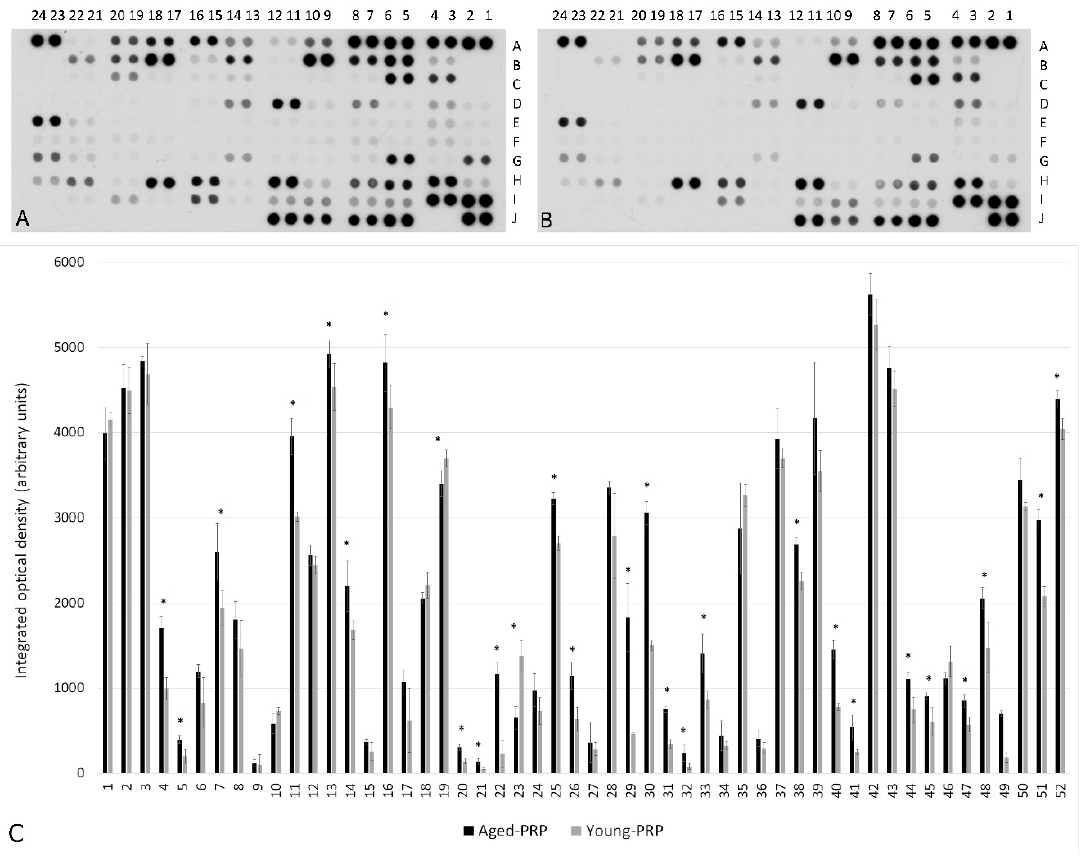
Figure 2. Molecular analysis of Young and Aged PRPs. Cytokine array of Aged PRP ( A ). Cytokine array of Young PRP ( B ). Molecular levels in the Aged PRP with respect to the Young PRP ( C ). The numbers and letter codes of panels A and B make reference to the coordinates of Table 4. The numbers of the X axis in panel C make reference to the number of each molecule in Table 4. * p < 0.05. Error bars = standard deviation. Table 3. Concentrations of growth factors and cytokines in Aged and Young groups.